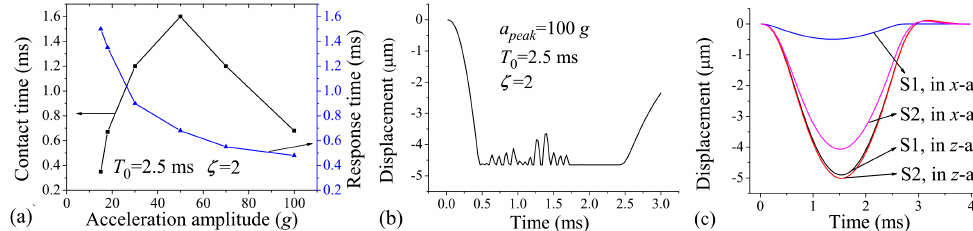
Figure 5. ( a ) Contact time vs. acceleration amplitude and response time vs. acceleration amplitude when T 0 = 2.5 ms and ζ = 2; ( b ) Displacement vs. time when a peak = 100 g , T 0 = 2.5 ms, and ζ = 2; ( c ) Displacement responses of two kinds of switches (S1 and S2) to the accelerations of 15 g and 2.5 ms applied in x - and z -axes.